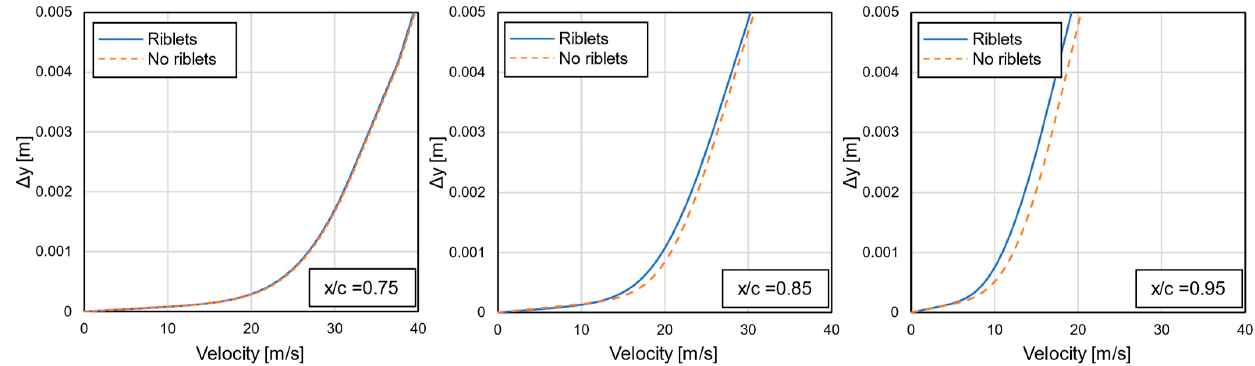
Figure 15. Velocity profiles on the MAC plane in selected positions, at design conditions.